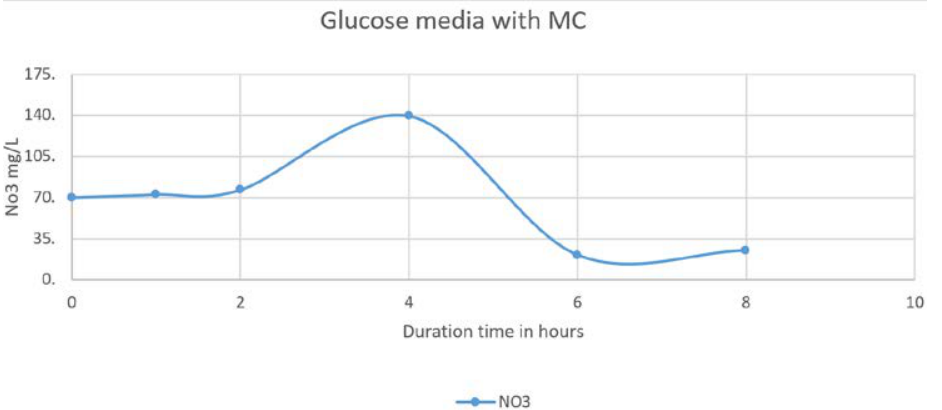
Fig. 7 . The nitrate was reduced on mineral media with glucose and MC. The higher reduction of nitrate was reached after 6 h (21 mg/L). The line shows the denitrification process starting from 70 mg/L. The denitrification began for four to five